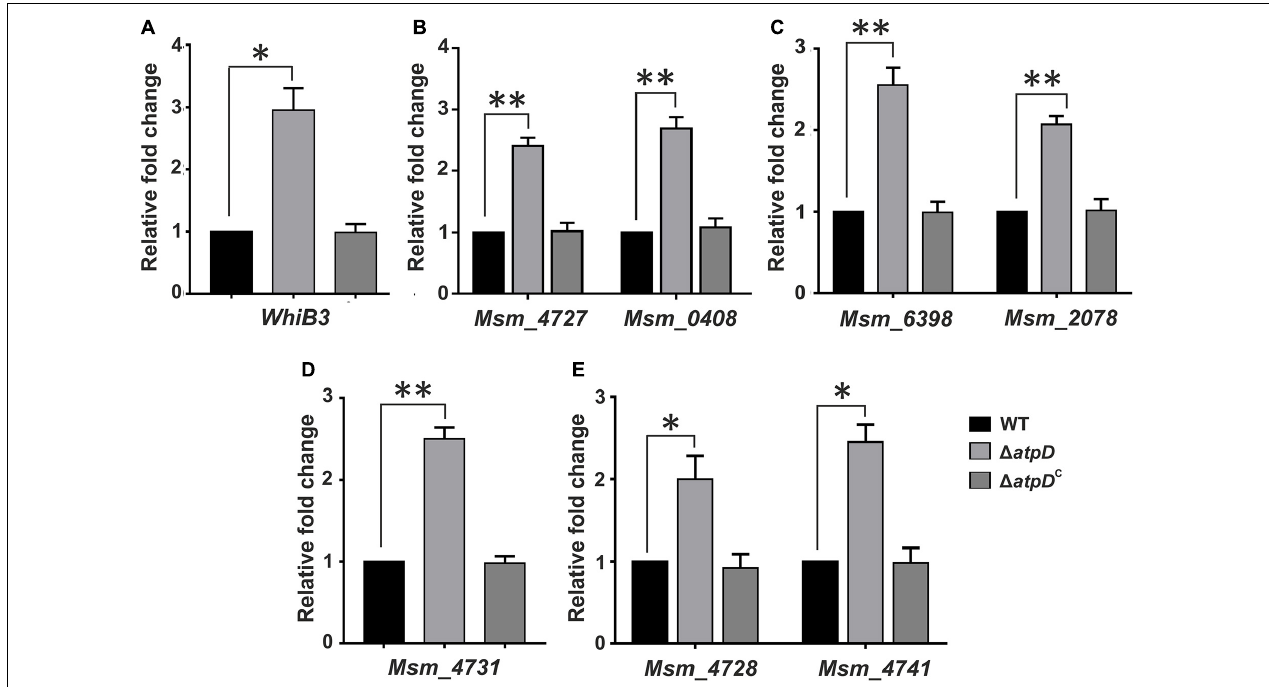
FIGURE 2 | Mycobacterium smegmatis (cid:49) atpD shows redox homeostasis under energy-deprived state. Shown are the relative mRNA transcript levels of redox sensor gene WhiB3 (A) , polyketide biosynthesis genes (B) , trehalose di-mycolate (TDM) biosynthesis genes (C) , polymethyl-branched fatty acid gene (D) , and polyketide synthase-associated protein (Pap) and mmpL genes (E) in M. smegmatis wild-type (WT), atpD knock out ( (cid:49) atpD ), and atpD -complemented ( (cid:49) atpD C ) strains. In all the panels, the transcript level in each case is compared with that of M. smegmatis WT, which is taken as 1. Data represent an average of at least three independent experiments with error bars representing standard deviation. ∗ P -value < 0.05; ∗∗ P -value <